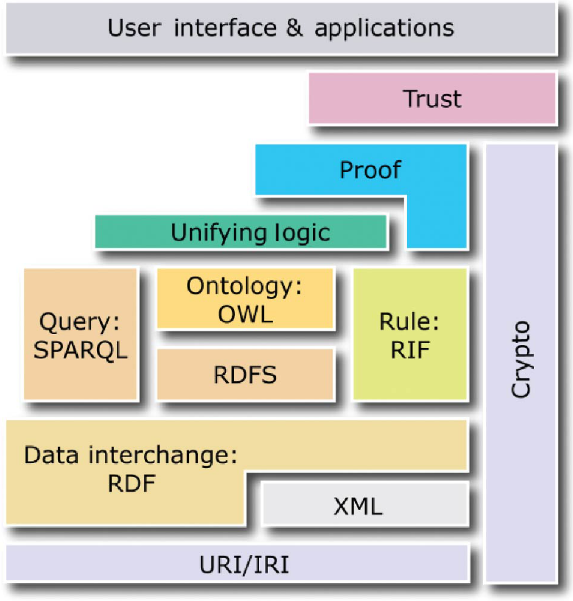
Figure 2: Web semantics and its different